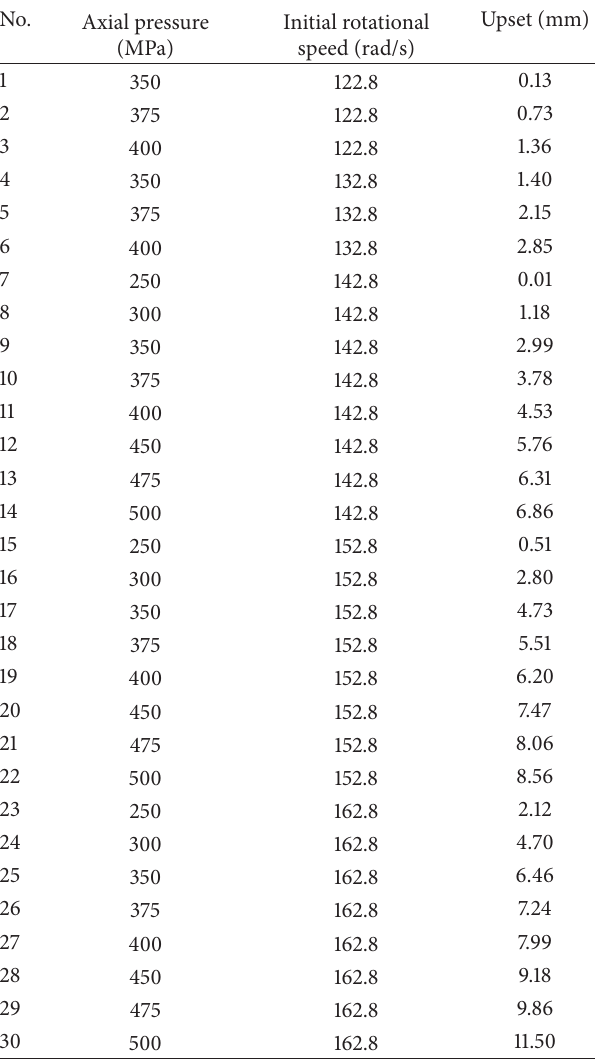
Table 3: The final upsets under different IFW processing parame- ters.